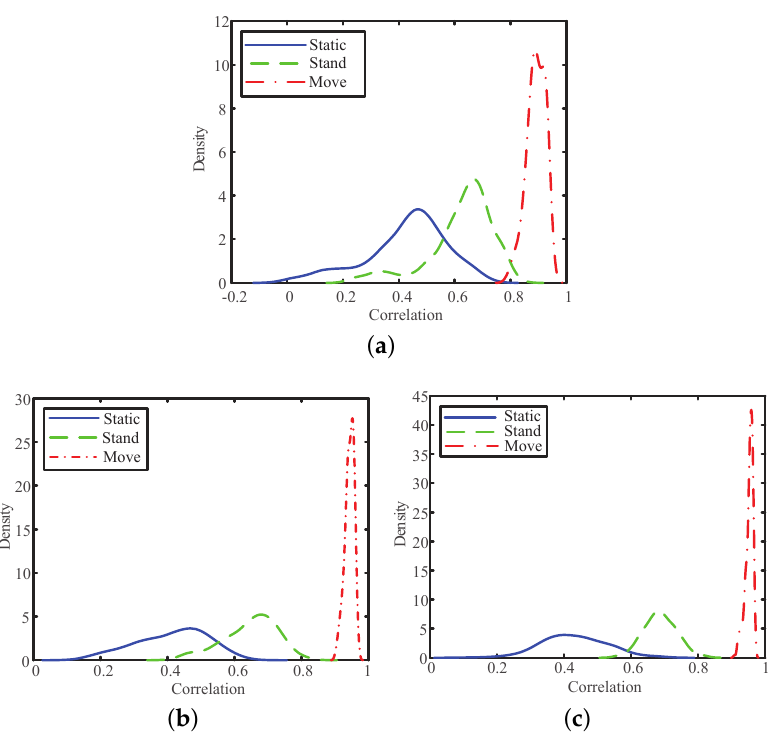
Figure 3. Kernel density images on three antennas. ( a ) antenna 1; ( b ) antenna 2; ( c ) antenna